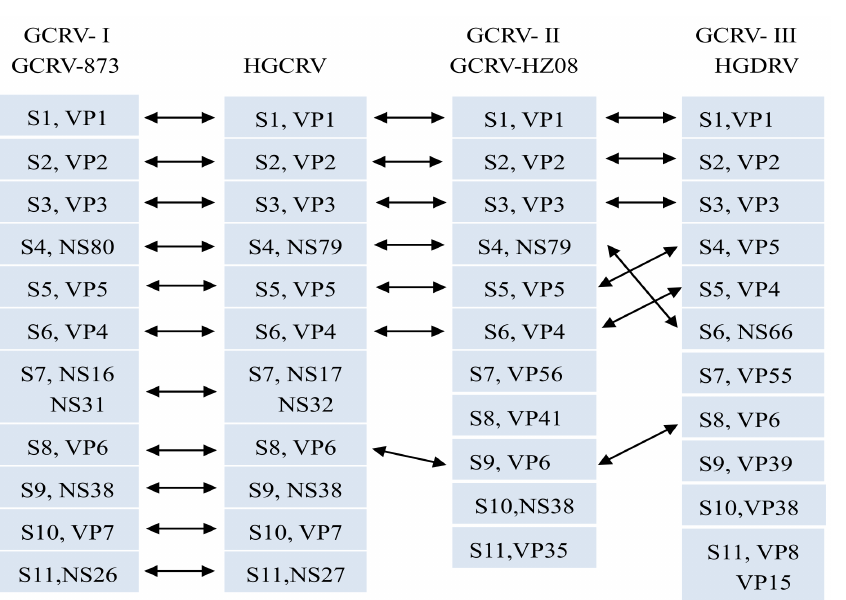
Figure 4. Predicted equivalent relationships of genome segments and proteins between HGCRV, GCRV-873 (GCRV-I), GCRV-HZ08 (GCRV-II), and HGDRV (GCRV-III). Double-headed arrows indi- cate equivalent segments and proteins. HGCRV, healthy grass carp